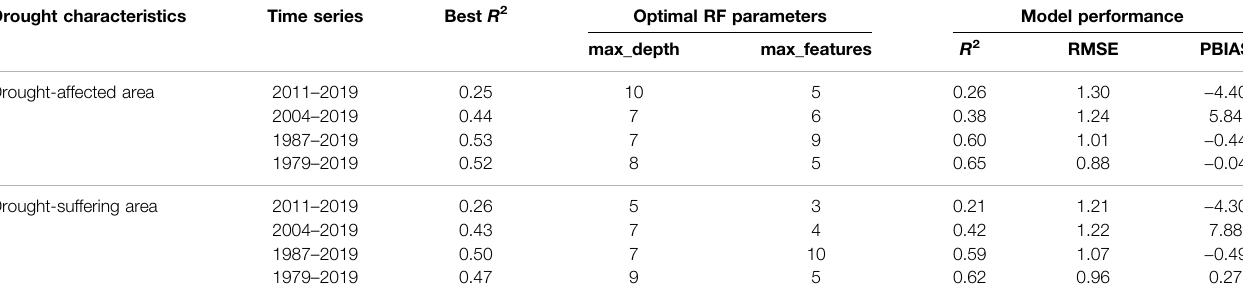
TABLE 5 | Optimal parameters and the corresponding model performance metrics of RF algorithms for drought-affected area and drought-suffering area Drought characteristics Time series Best R